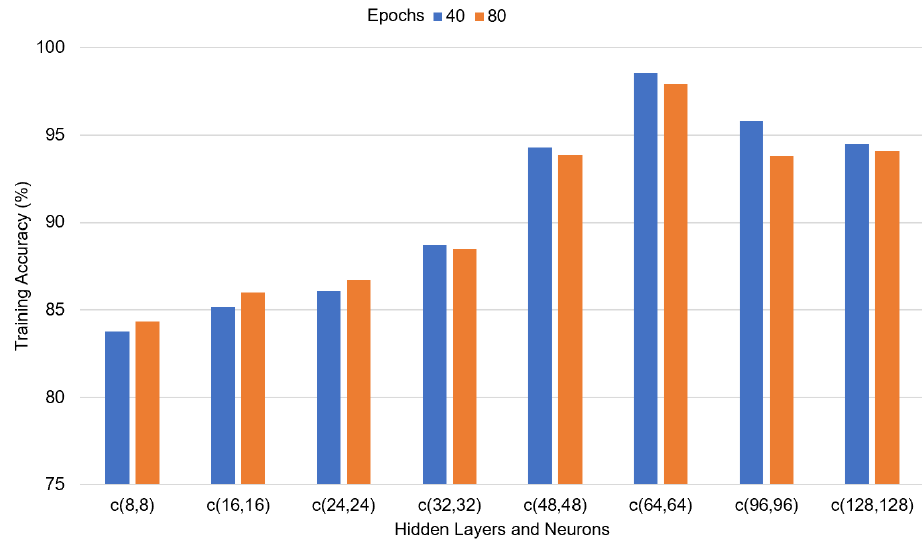
Figure 2. Self-training mechanism of the SVSL method.